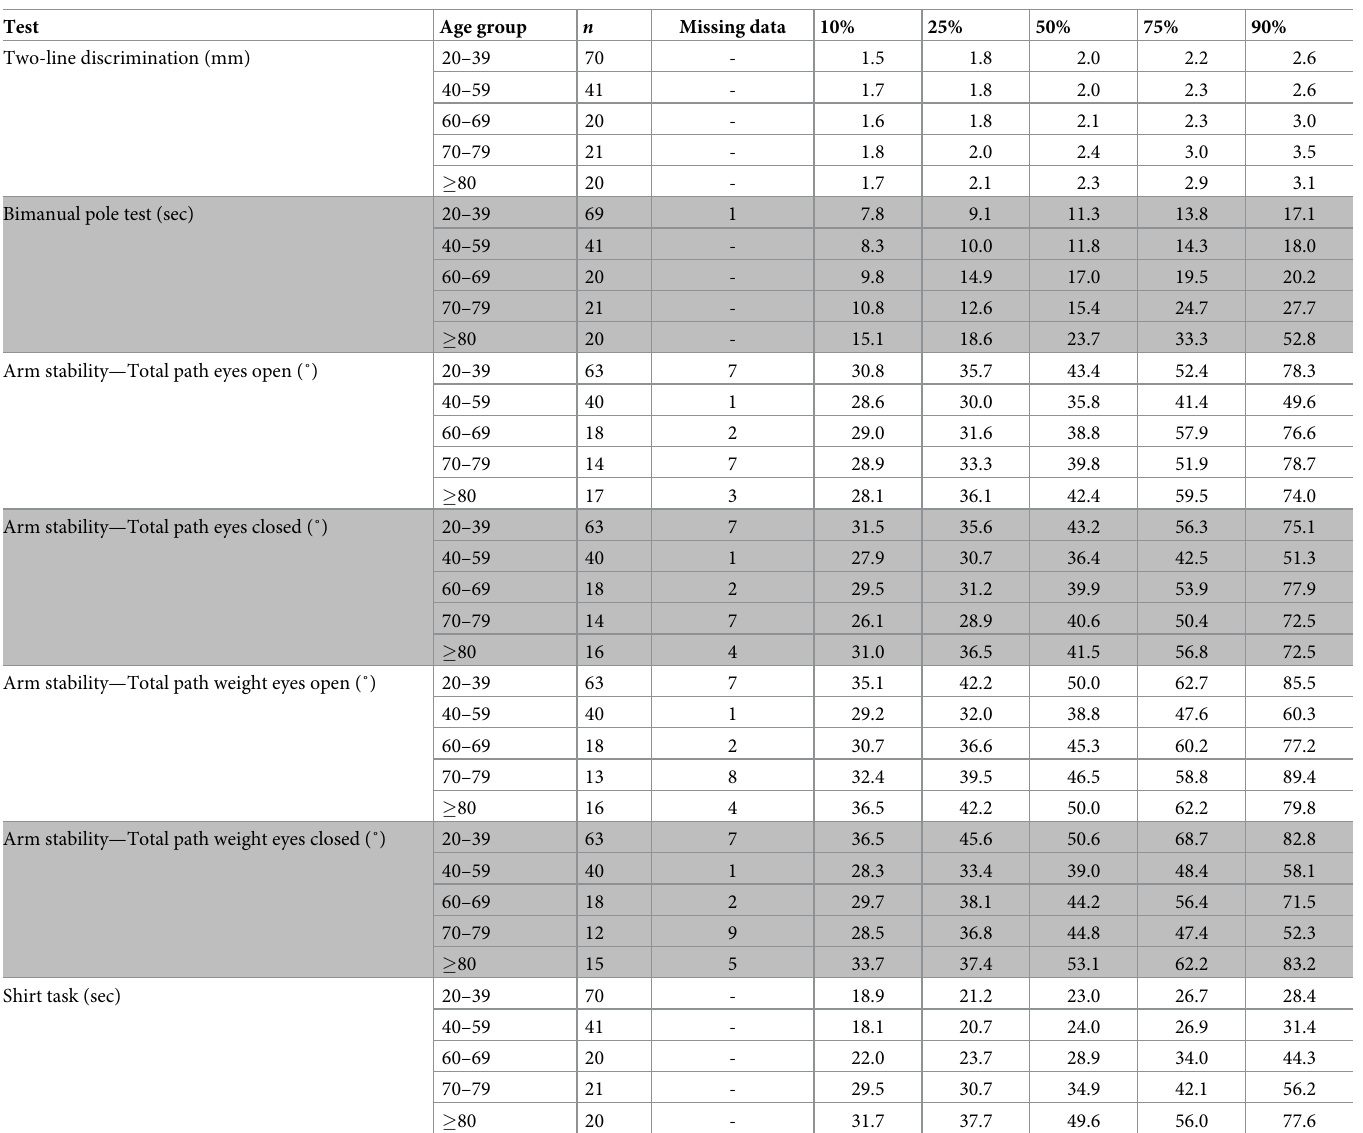
Test-retest statistics for each test are shown in Table 4. Intra-class correlation coefficients